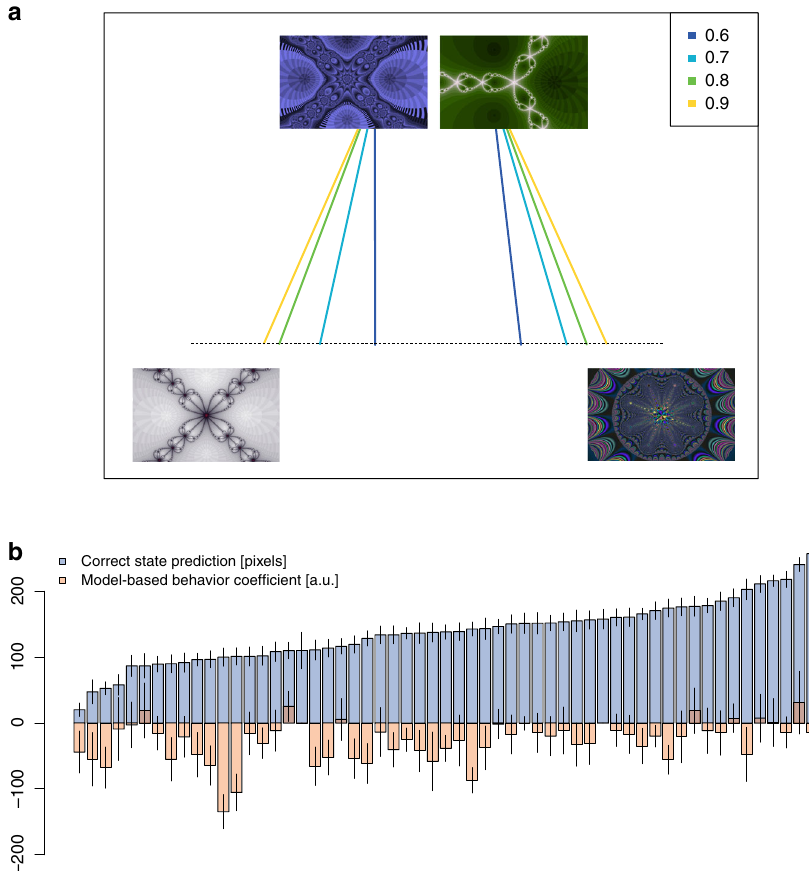
Fig. 3 Mouse-tracking results: stochastic task. a Ballistic mouse trajectories in the stochastic task. Each colored line represents the average cursor path between a top fractal and a bottom fractal for a speci fi c transition probability (yellow = 0.9, green = 0.8, light blue = 0.7, dark blue = 0.6). For illustration, we only present the paths between fractals on the same side of the screen, in cases where subjects ’ predictions were correct. We only measure the cursor ’ s starting point and the point at which it crosses the line, connecting those two points with a straight line. b Individual subject estimates in the stochastic task. In blue: distance towards the correct (common transition) side of the screen (in pixels), in increasing order (error bars represent s.e.m. based on N = 400 trials for each subject). In orange: inverted regression-coef fi cient measure of model-based behavior from Fig. 2a-c (in arbitrary units, with positive values denoting more model-based behavior, errors bars represent standard error of the regression coef fi cient of each individual subject based on N = 400 trials). Source data are provided as a Source Data fi